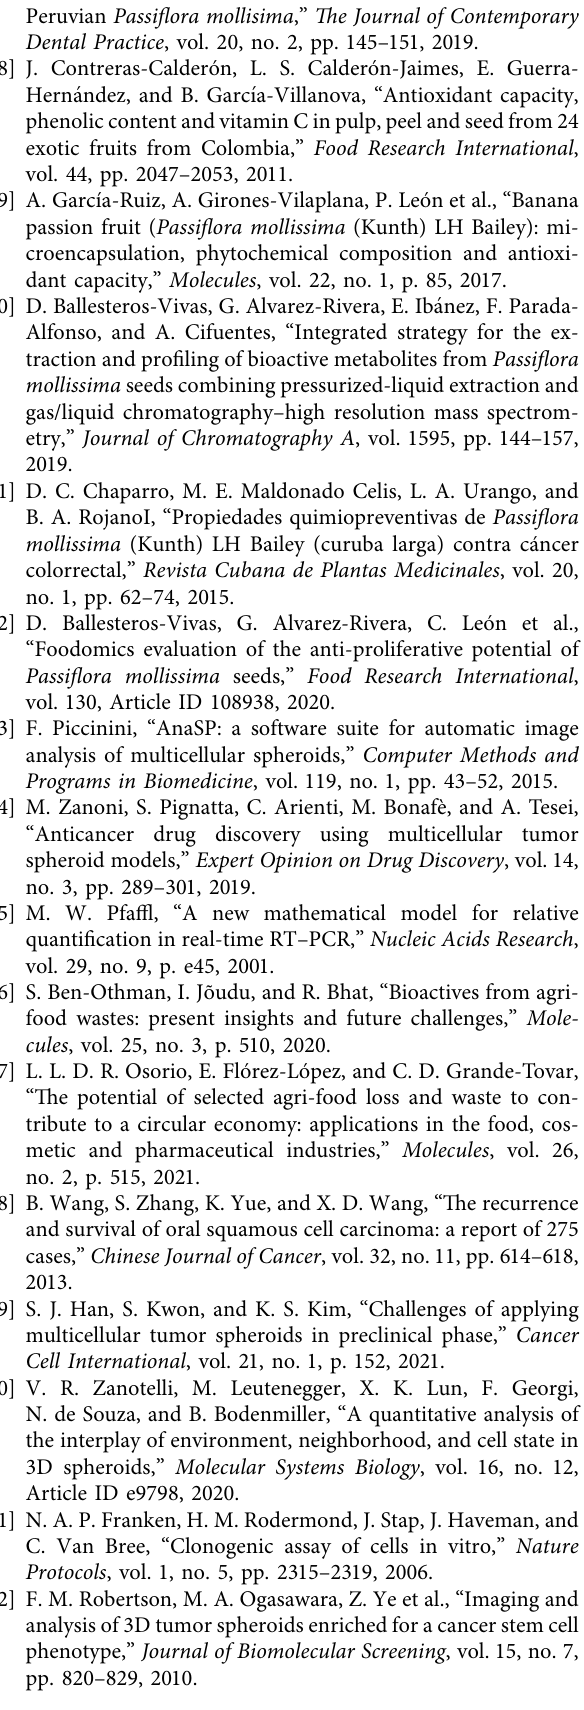
Figure 1. Dose-response curve of effects on cell viability of Human Gingival fibroblast treated with PME. Figure 2. Spheroids of CAL 27 at different cell number and FBS percentage. Figure 3. Measurements spheroids of CAL 27 untreated. Figure 4. Variation in Ct values of the house- keeping genes across all the cDNA samples. ( Supplementary Materials